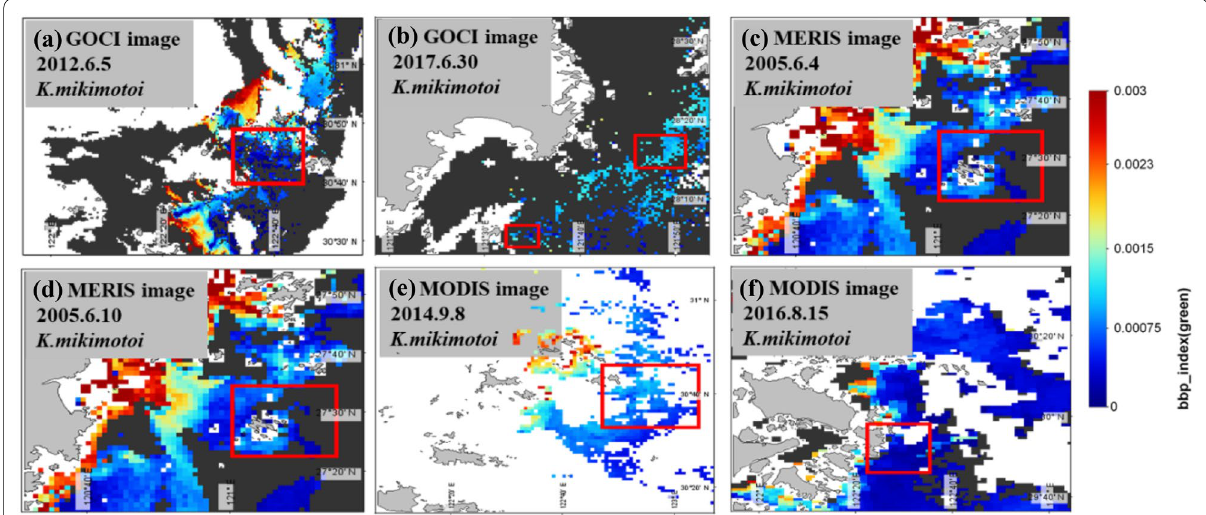
( green ) of Karenia mikimotoi blooms water during 2004–2020. a , b b bp_ ( green ) map derived by GOCI Fig. 2 Satellite imagery derived b bp_ index index ( green ) map derived by MERIS images. e , f b bp_ ( green ) map derived by MODIS images. The highlighted regions (red images. c , d b bp_ index index rectangles) indicate occurrences of K. mikimotoi blooms that were recorded by State Ocean Administration (SOA) and the Bulletin of China Marine ( green ) . The black pixels indicate area of non-bloom area Disaster by Zhejiang Ocean Forecast. The color bar represents the variation of b bp_ index